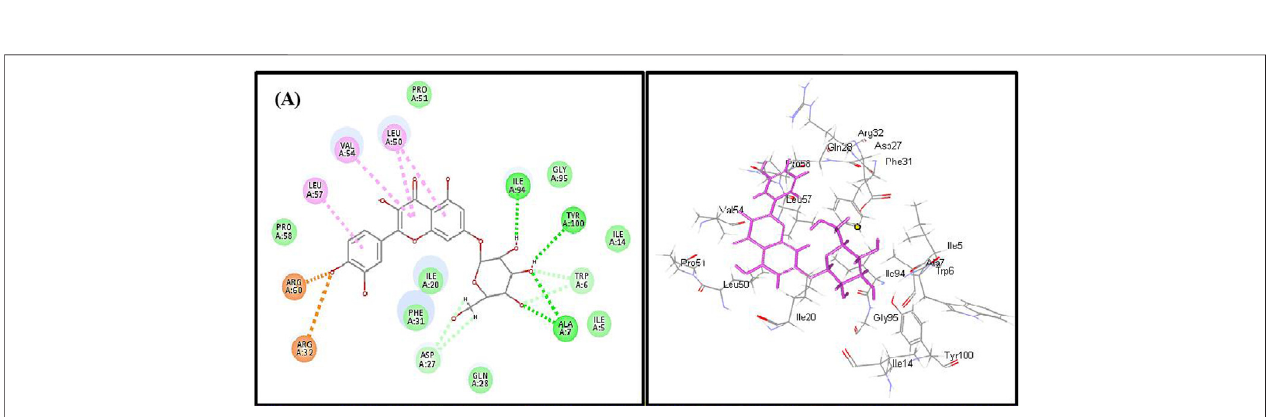
FIGURE 5 | 2D and 3D binding modes of quercetin 7-O- β -D -glucoside in dihydrofolate reductase active sites; dotted green lines indicate H-bonds; dotted light green lines indicate C-H-bonds; dotted purple lines indicate π -bonds; dotted orange bonds indicate salt bridge formation.